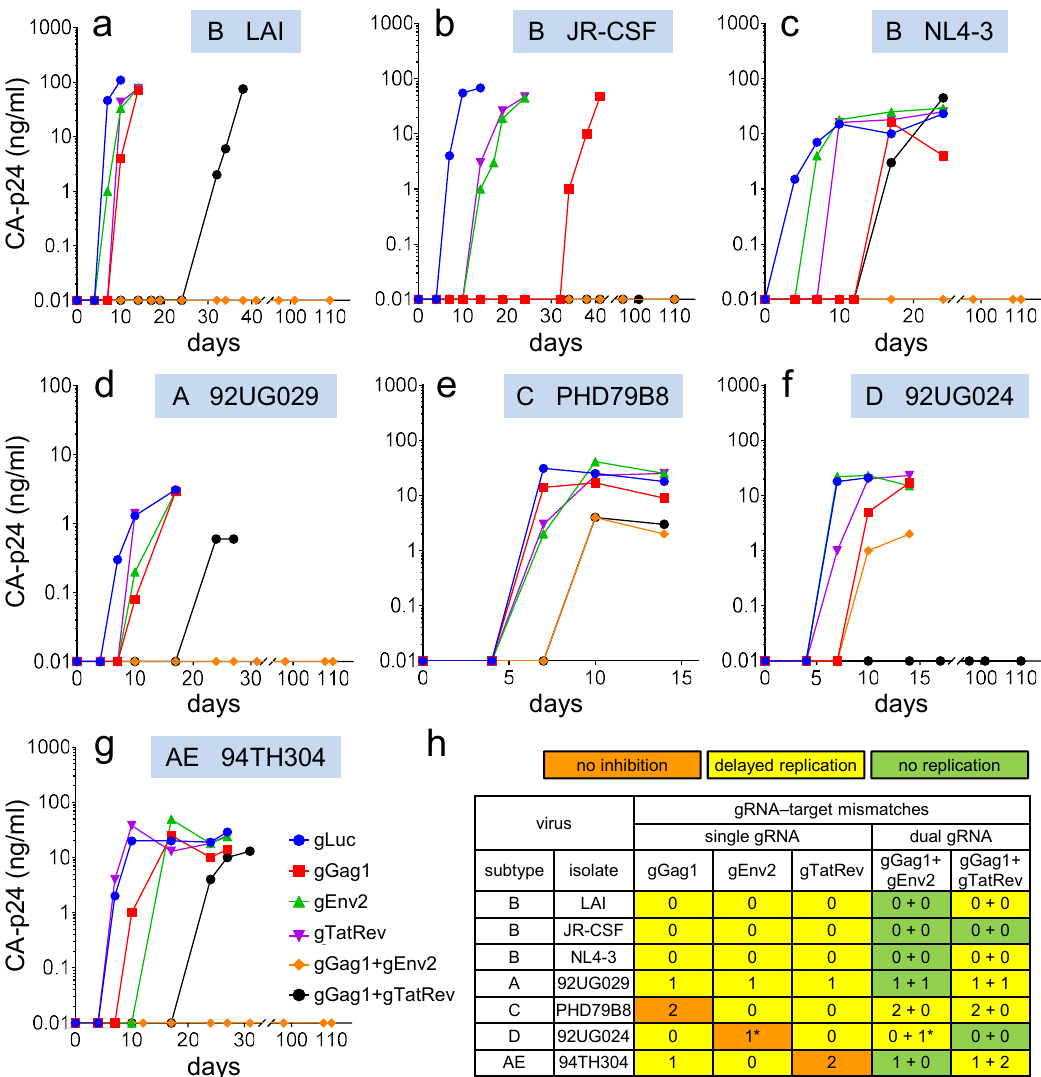
Figure 2. Replication of HIV-1 isolates in Cas9-gRNA-expressing T cells. Jurkat T-cells stably transduced with lentiviral vectors expressing Cas9 and single or dual gRNAs were infected with the different HIV-1 isolates and cultured for up to 110 days. ( a–g ) The CA-p24 level in the culture supernatant was measured to monitor virus replication. All viruses were tested in four cultures and one representative culture is shown. ( h ) Replication in the presence of the antiviral gRNAs was compared to replication in control gLuc-expressing cells (as shown in a–g). The color indicates the effect of the gRNAs on virus replication (orange, no inhibition; yellow, delayed replication; green, no replication). The number of nt mismatches in the viral targets are shown (*, nt mismatch at Cas9 cleavage site). Most notably, no virus inhibition was scored for isolates with two mismatches in the target sequence (C isolate in gGag1 cells and AE isolate in gTatRev cells; orange in Figure 2h). This result indicates that Cas9 does not tolerate two mismatches in the target sequence, not even when these nt are positioned far from the PAM, like in the AE isolate. Replication of virus isolates without mismatches was consistently delayed (yellow in Figure 2h), irrespective of the subtype, receptor tropism (R5 or X4) or source (primary isolate or laboratory-adapted strain). Similarly, replication of virus isolates with a 1-nt mismatch in the middle of the target sequence or more distal to the PAM was transiently inhibited (A isolate in gGag1, gEnv2 and gTatRev cells; AE isolate in gGag1 cells). In contrast, replication of the D isolate was not noticeably inhibited by gEnv2, while this virus also carries only a single